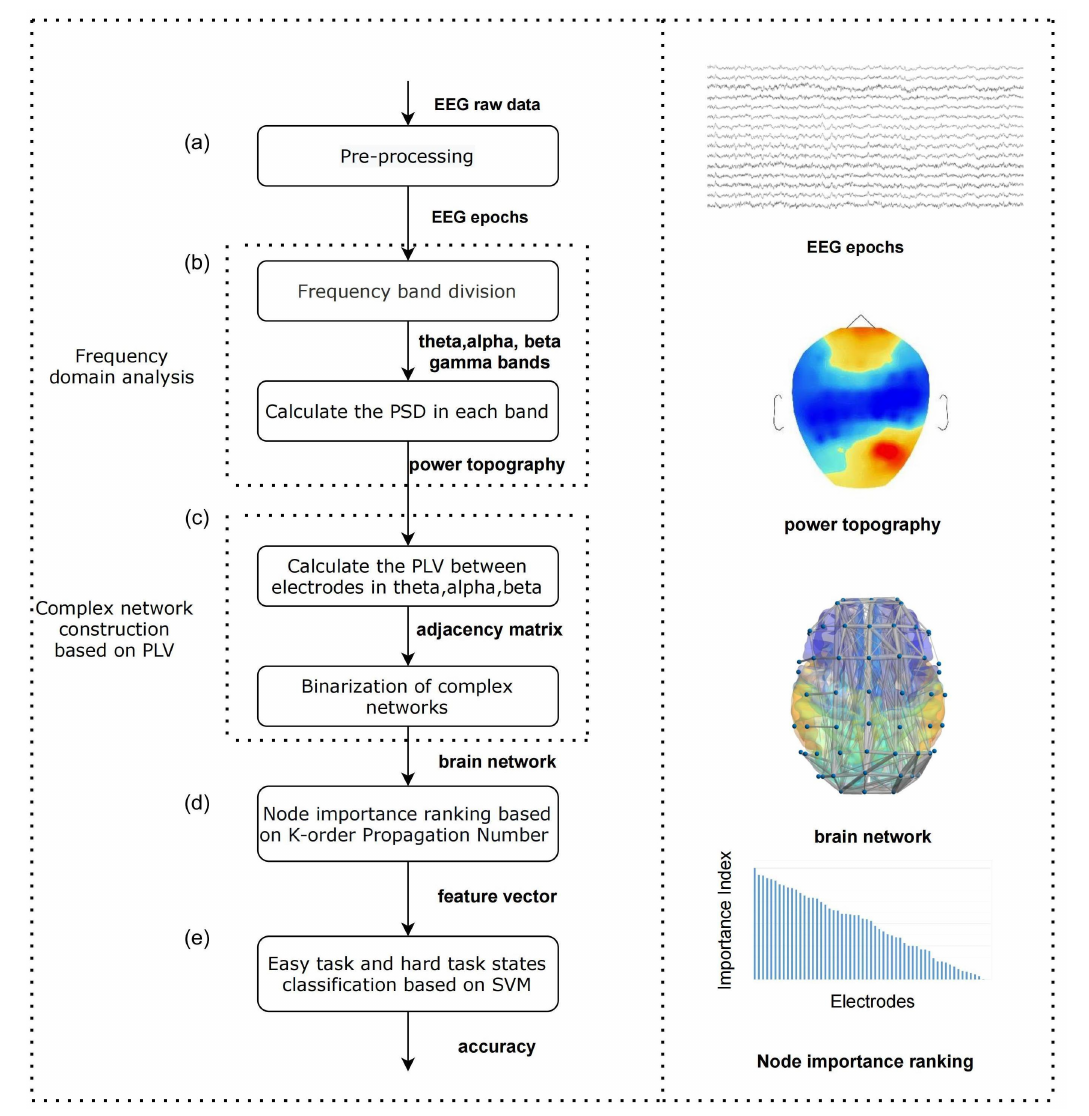
Figure 2. Algorithm configuration. The data processing steps in the algorithm were shown as ( a – e ). ( a ) Pre-processing the raw EEG data. ( b ) Perform band division and power spectrum estimation on the processed data. ( c ) Calculate the phase-locked values between EEG channels in the interested frequency bands to construct a normalized brain network. ( d ) Node importance analysis based on the brain network. ( e ) Classification of working memory states based on node importance features of brain networks. The visual diagram of the processed data is shown at the right. EEG epoch is obtained after pre-processing. The power topography is generated by the PSD in theta band. The brain network is obtained based on the PLV adjacency matrix binarization, and the reasonable selection of the threshold value can effectively distinguish the networks with large differences in